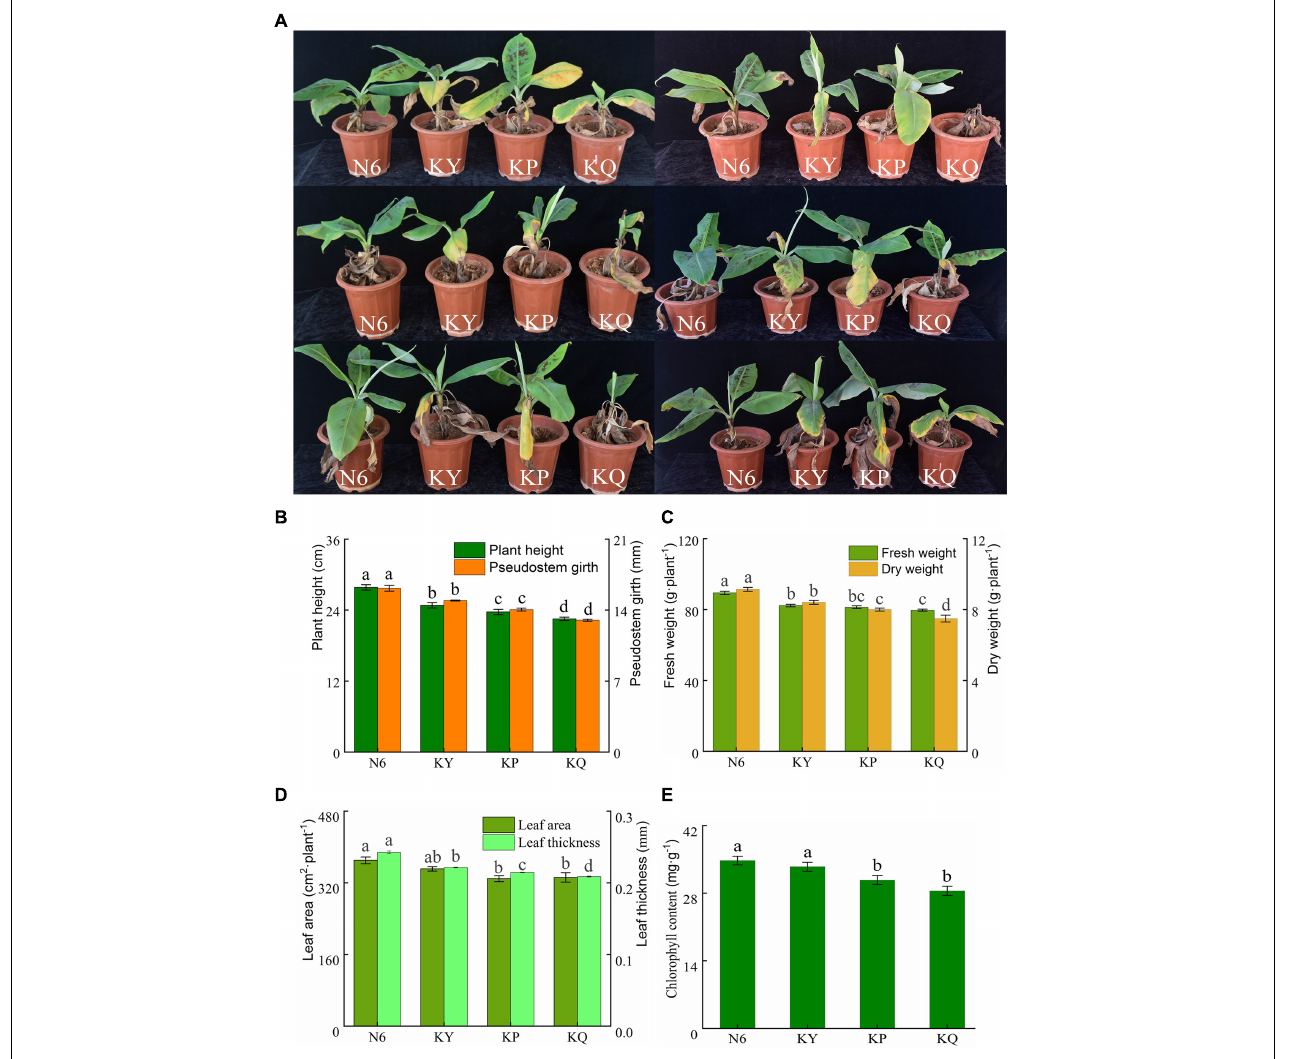
FIGURE 2 | The biocontrol effects of strain HN6 against FOC4. N6 ( Foc · TR4-GFP + HN6, 1.0 × 10 7 cfu g − 1 soil), KY ( Foc · TR4-GFP + 0.1% carbendazim), KP ( Foc · TR4-GFP + Gause No. 1 liquid medium), and KQ ( Foc TR4-GFP + sterile water). YS referred to rhizosphere soil of uninoculated plants. (A) The incidence of banana seedlings in different treatment groups. (B) Plant height and pseudostem girth. (C) Fresh and dry weights. (D) Leaf area and leaf thickness. (E) Chlorophyll content. Error bars represent standard deviations, and means with different letters are significantly different from each other ( p < 0.05) according to the least significant difference (LSD) test ( n =